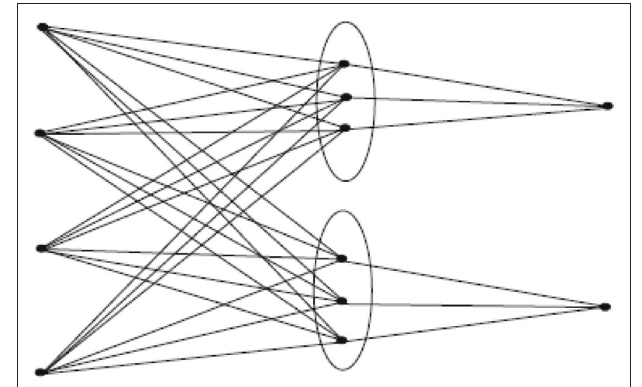
FIGURE 1 | PNN (4,2,3).